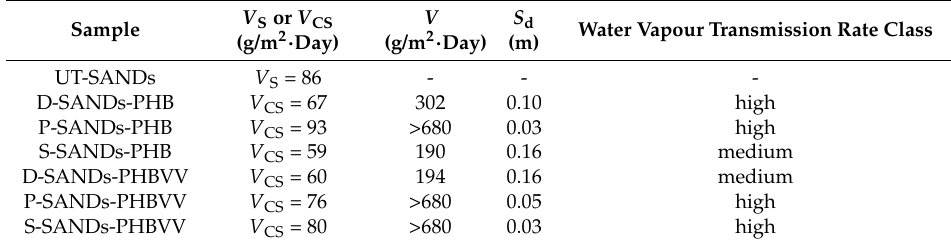
Table 9. Results of water vapour diffusion test for sandstone treated with PHB and PHBVV and untreated.